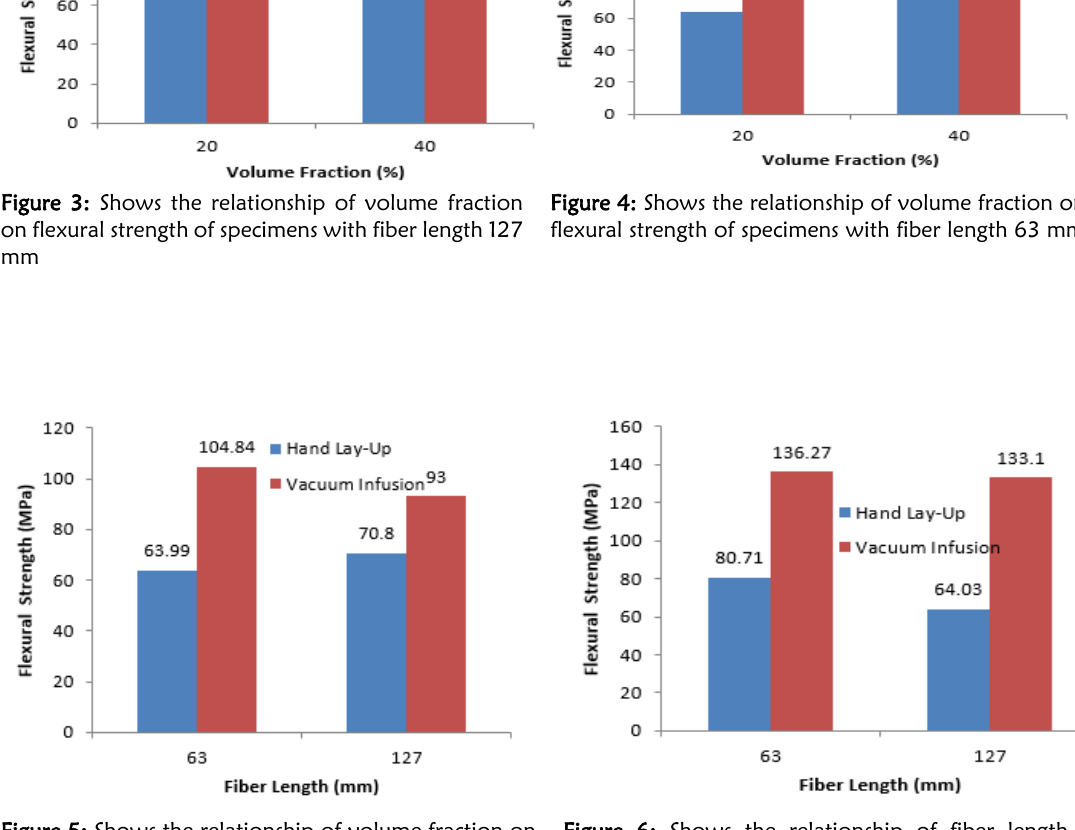
Figure 6: Shows the relationship of fiber length on flexural strength of specimen with volume fraction